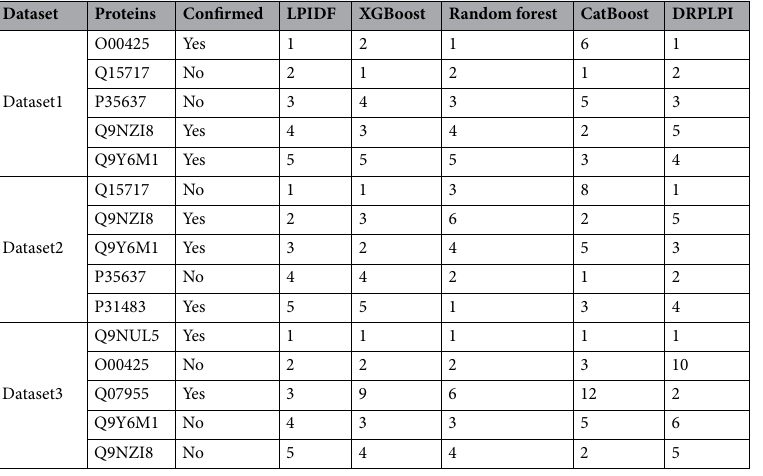
Table 5. The predicted top 5 proteins interacting with